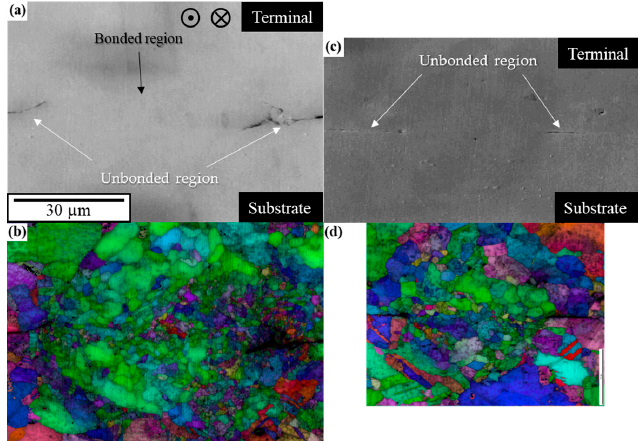
Figure 7. Results of ( a ) peel strength and ( b ) bonding area of the C1020 joints and the C1940 joints before and after the thermal cycling test.